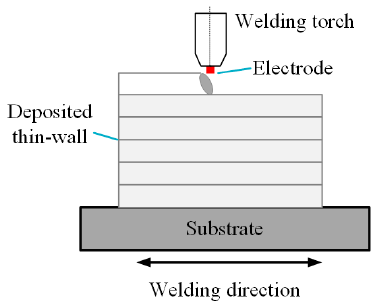
Figure 2. Schematic diagram of the robot additive manufacturing process. Table 2. Forming process parameters of four